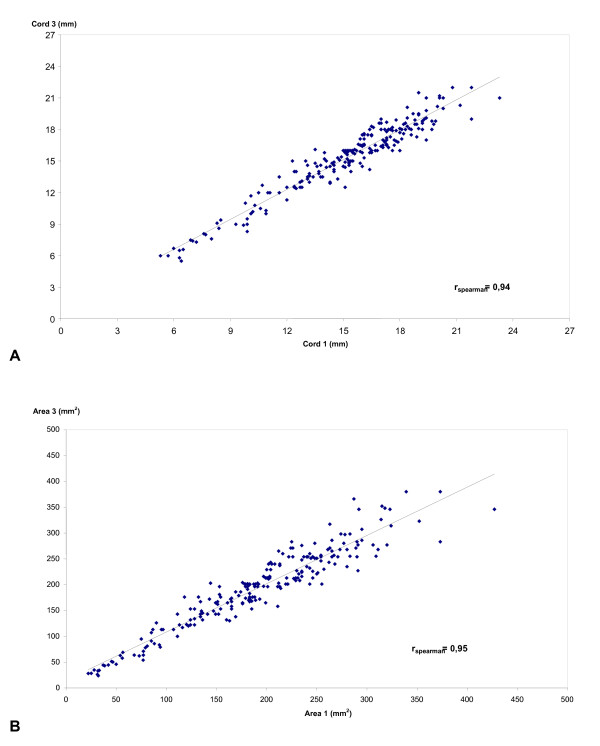
Linear correlation (r = correlation coefficient of Spearman) of the intra-observer ultrasonographic measurements: A. of the diameter of the umbilical cord (cord1 and cord3 are respectively the first and second measurements of observer 1); and B. of the cross-sectional area of the umbilical cord (area1 and area3 are respectively the first and second measurements of observer 1).